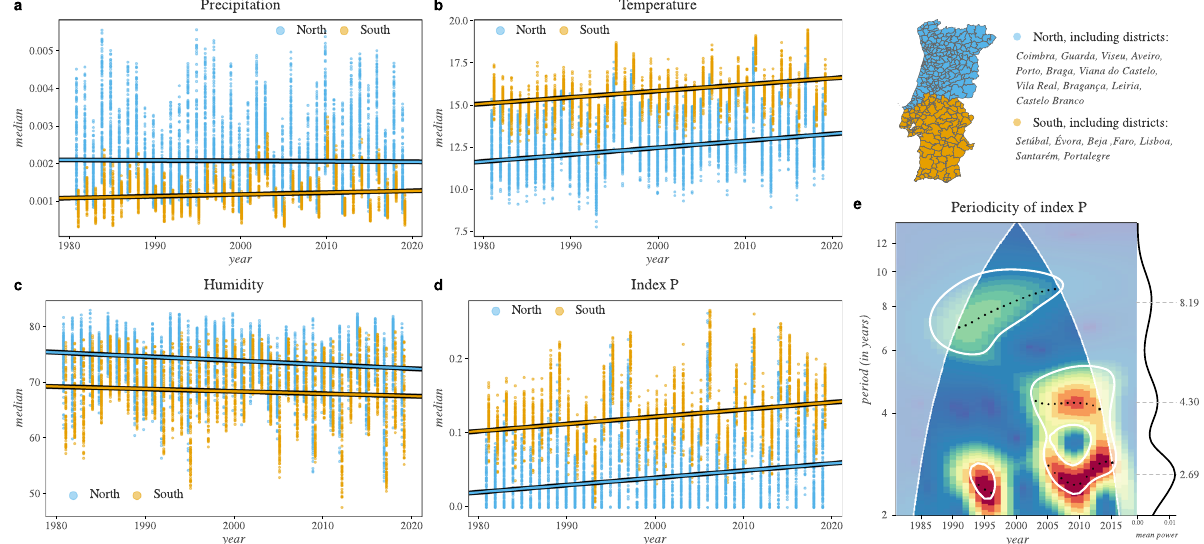
Fig. 6 Long-term trends and periodicity of transmission potential of WNV and climate across different regions of Portugal. a , b and c present the median of climatic variables among counties (points) within the north (blue) and south (orange) regions de fi ned by the set of districts listed in the map subpanel (on the right). d Presents the same as a – c but for the index P (transmission potential). e Presents the cross-wavelet transform of the median yearly transmission potential between north and south time-series. Signi fi cant periodic components are circled in white ( p (cid:3) value < 0 : 01), where the heat map denotes power with peaks indicated by black dots (wavelet ridges) and mean power throughout time shown in the right